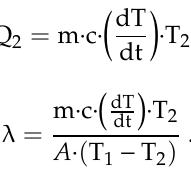
Figure 5. Lee’s apparatus.